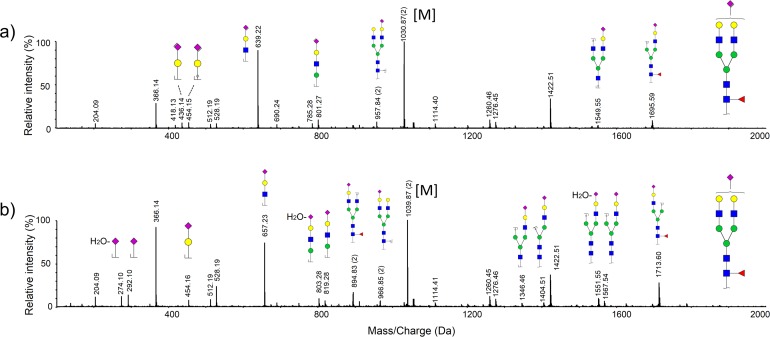
NanoLC-ESI-MS/MS spectrum of native glycans.a) MS/MS spectra of m/z 2060 with chemical composition of GlcNAc4Man3Gal2NeuAcLac1; b) MS/MS spectra of m/z 2078 with chemical composition of GlcNAc4Man3Gal2NeuAc1.